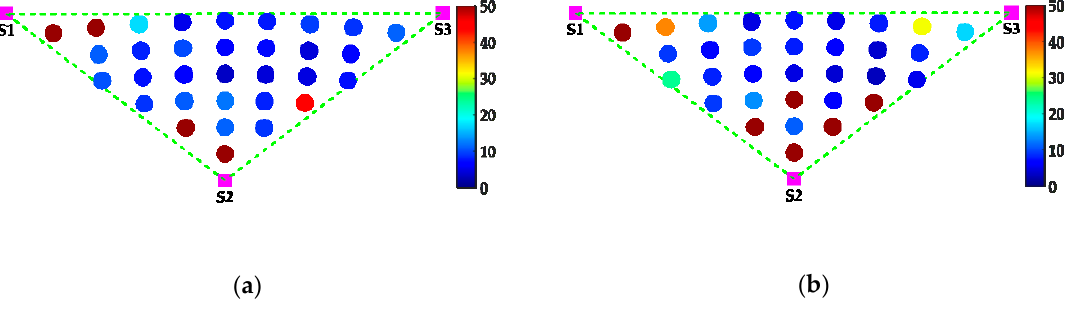
Figure 17. The distribution of absolute errors using the fixed parameters: ( a ) fixed threshold amplification factor; ( b ) fixed threshold.